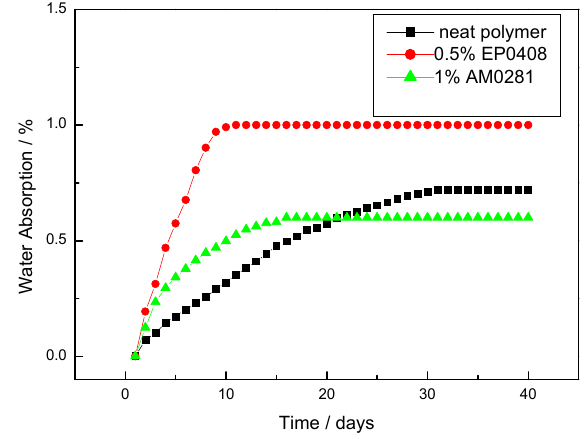
Figure 13. Water absorption of the phthalonitrile polymer and the phthalonitrile–POSS copolymers in ambient conditions.